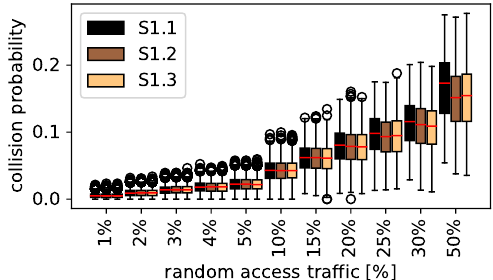
Figure 6. Scheduled and random access: traffic